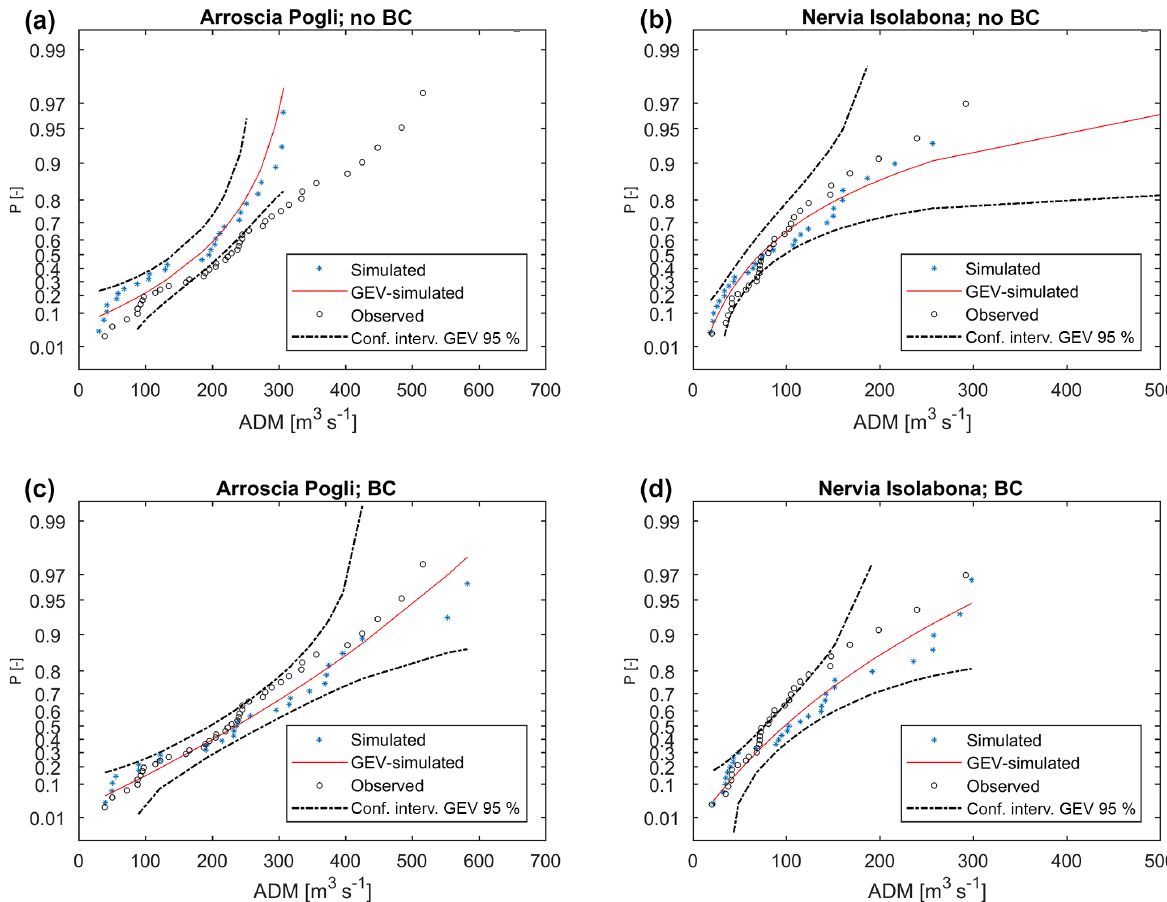
Figure 10. Same as Fig. 8 but for Neva closed at Cisano (123km 2 ) and Nervia closed at Isolabona (122km 2 ).